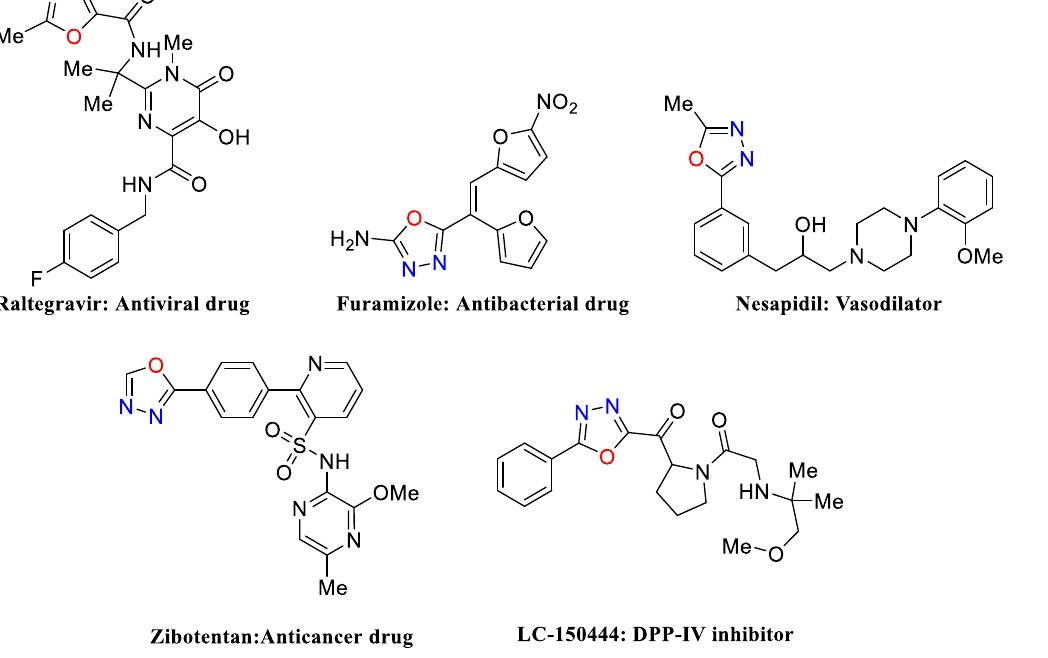
Figure 1. 1,3,4-Oxadiazole as a pharmacophore in commercial and preclinical stage drugs. Quinoline, a fused structure of benzene and pyridine at two adjacent carbon atoms, is known to possess diverse biological and pharmaceutical potential. Naturally occurring quinoline-containing compounds and synthetic derivatives of quinoline have shown